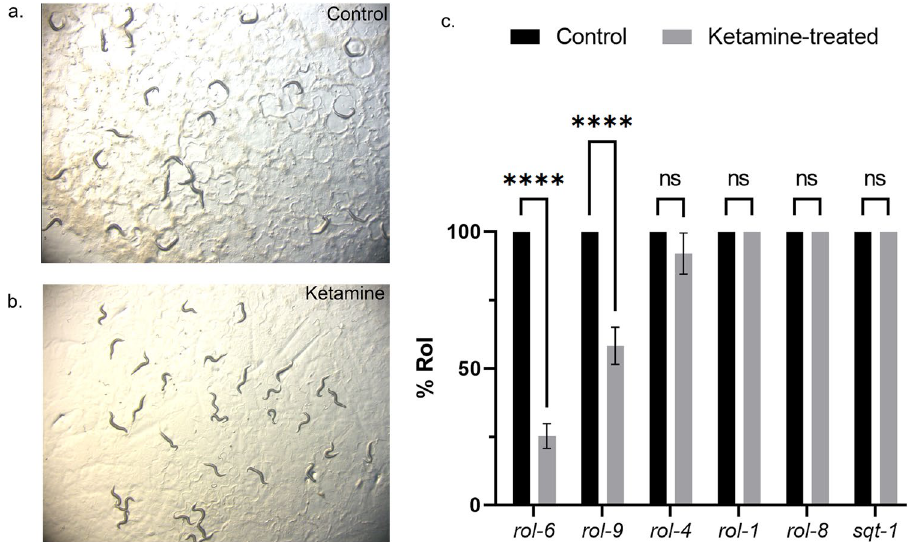
Figure 7. Ketamine-treatment ameliorates the roller phenotype of collagen mutants ( a ) rol-6(e187) mutant with circular movement pattern is shown ( b ) Ketamine-treatment ameliorated the movement defect of rol-6(e187) mutants ( c ) Collagen mutants are tested for their roller phenotype suppression upon ketamine-treatment. rol-6 (n = 295) and rol-9 (n = 327) mutants’ movement defect was significantly ameliorated with ketamine treatment (Two-way ANOVA with Šídák’s multiple comparisons test, mean ± sem, **** p < 0.0001 for both mutants). rol-1 , rol-4 , rol-8 , sqt-1 collagen mutants continued to display roller phenotype upon ketamine-treatment with a slight decrease in rol-4 mutants without significant changes ( p = 0.0588 for rol-4 and p > 0.9999 for the rest, ns: not significant).